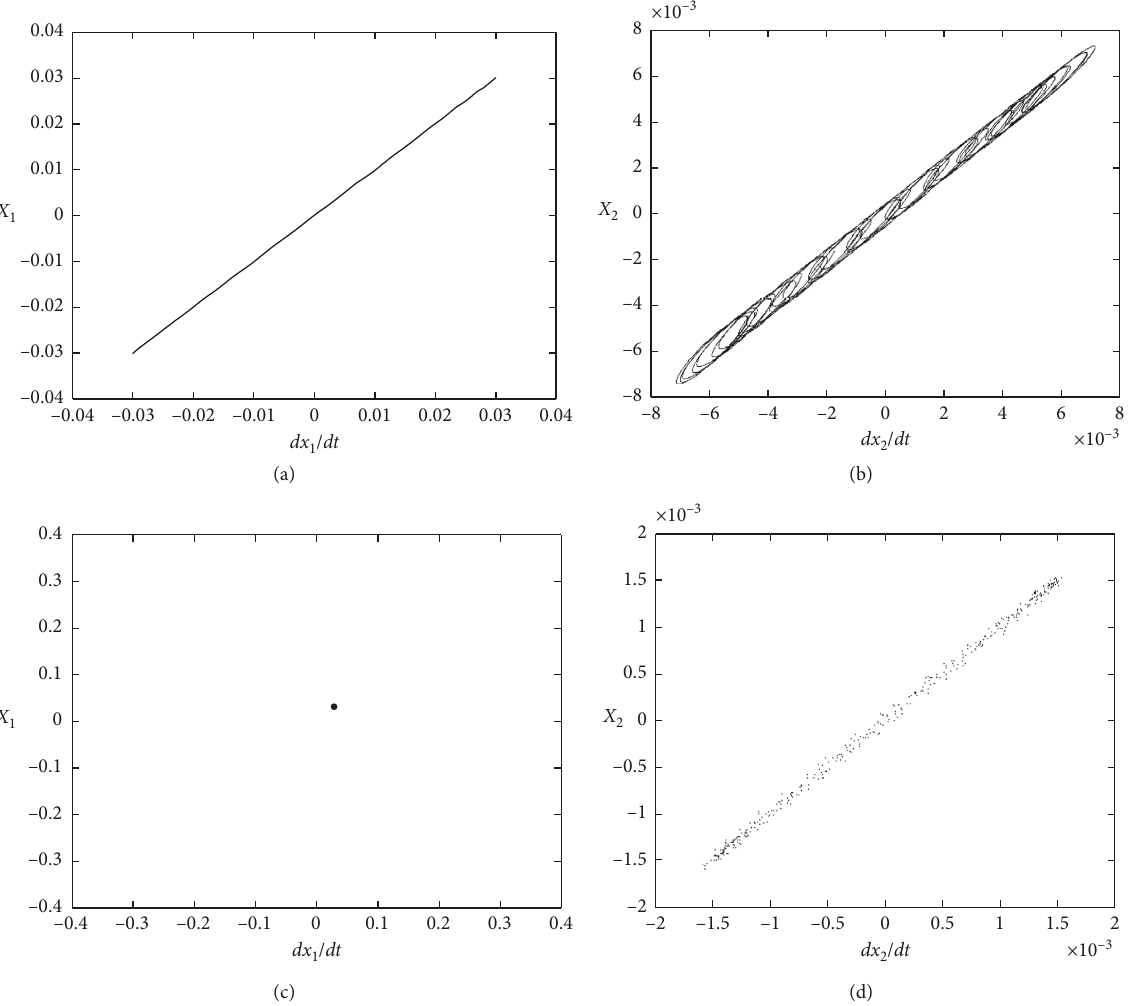
0 . 2, α 2 2 . 5, and F 0 . 9. (a) Phase diagram in x 1 direction. (b) Phase (cid:31) (cid:31) (cid:31)